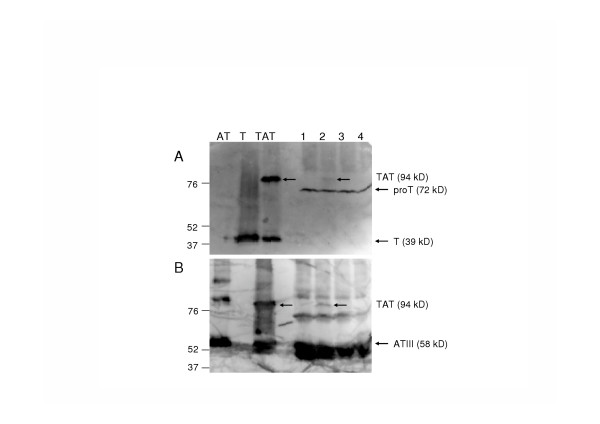
Antithrombin (lane AT), thrombin (lane T) and in vitro TAT complexes (lane TAT) were separated on a 7.5% acrylamide gel and transferred to a nitrocellulose filter. Plasma samples of control mice (lane 1) or mice treated with 50 μg/ml LPS for 2 (lane 2), 6 (lane 3) and 24 hours (lane 4) were separated also. The filters were incubated with 1000-fold diluted serum from a rabbit immunized with thrombin (A), or serum from a rabbit immunized with AT (B).